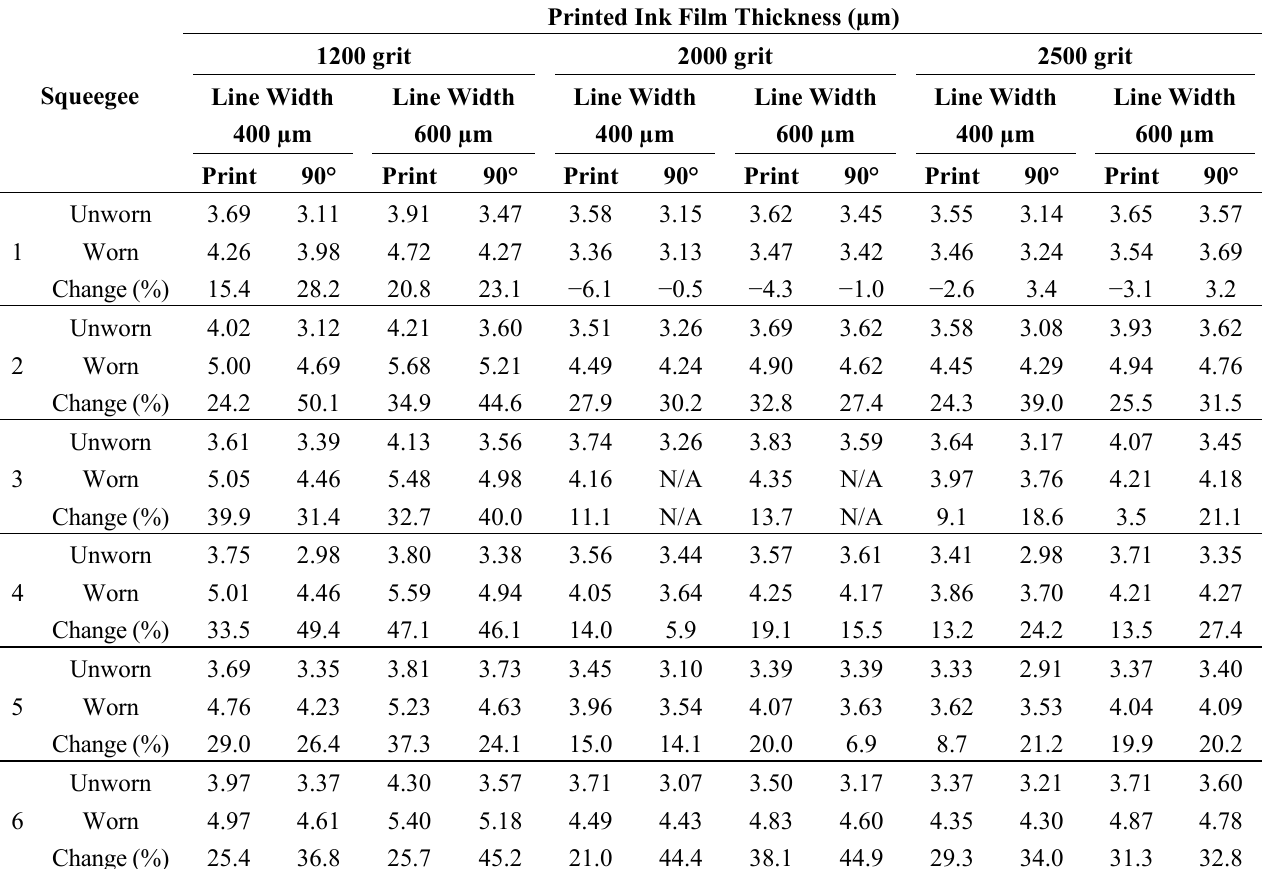
Table 8. Printed ink film thickness (µm) in unworn and worn states and percentage change in ink film thickness as a result of squeegee wear for lines printed in the print direction and at 90° (parallel to